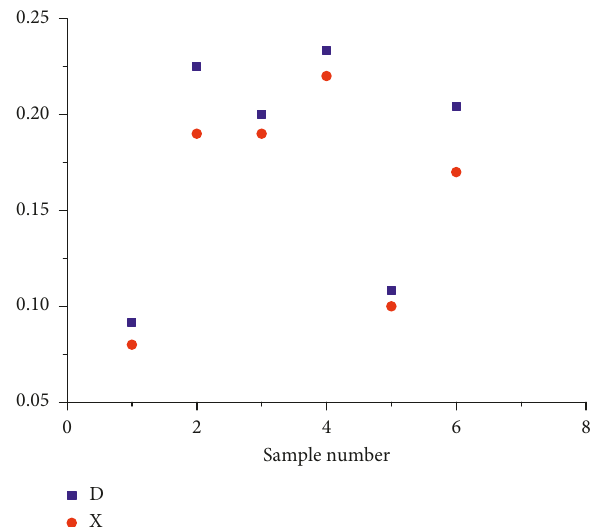
Figure 8: Relation between χ and the elastic model damage.